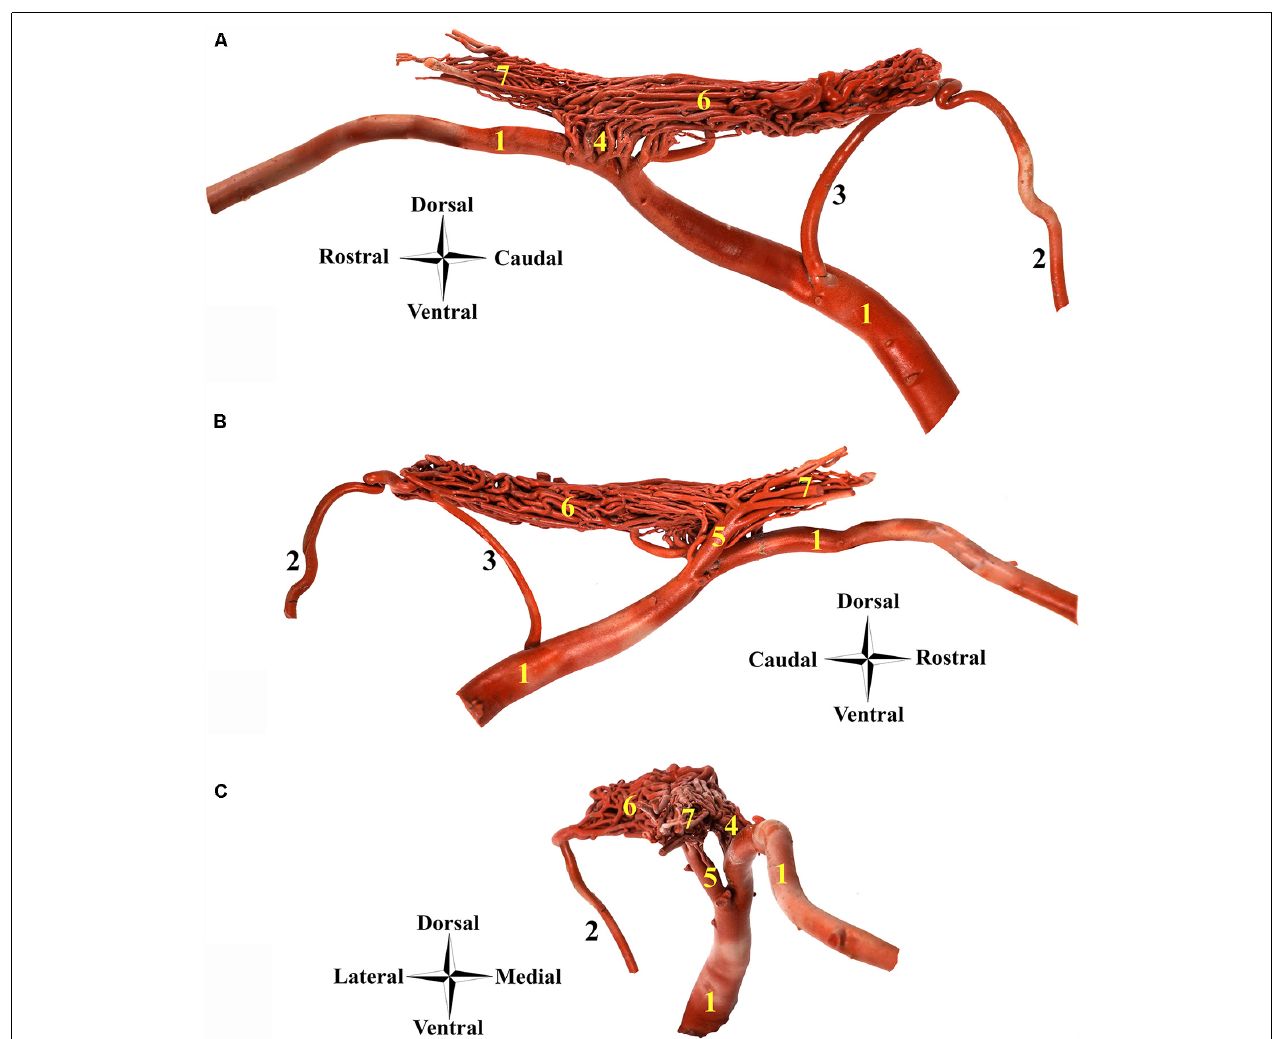
FIGURE 4 | Afferent arteries to the RERM in the dromedary. (A) Right medial view, (B) right lateral view and (C) rostral view; 1, maxillary artery; 2, internal carotid artery; 3, middle meningeal artery; 4, rostral branches to the RERM; 5, external ophthalmic artery; 6, RERM; and 7, ophthalmic rete. Note: this specimen contains a dominant middle meningeal artery contribution to